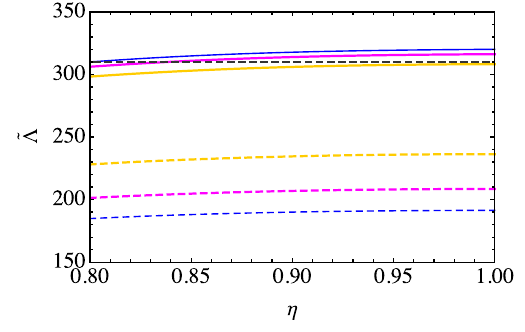
Fig. 6 Combined tidal deformability ˜ (cid:2) as a function of mass ratio η , calculated by the astrophysically compatible EOSs for the case of GW190425. The black-dashed line stands for ˜ (cid:2) = 310 . 1 Table 3 Combined tidal deformabilities of strange quark stars for the case of GW190425: the ratio ˜ (cid:2) | η = 0 . 8 / ˜ (cid:2) | η = 1 . 0 , the upper bound of combined tidal deformability ˜ (cid:2) UB , the lower bound of combined tidal deformability ˜ (cid:2) LB , with different strange quark masses m s 0 m s 0 ( MeV )